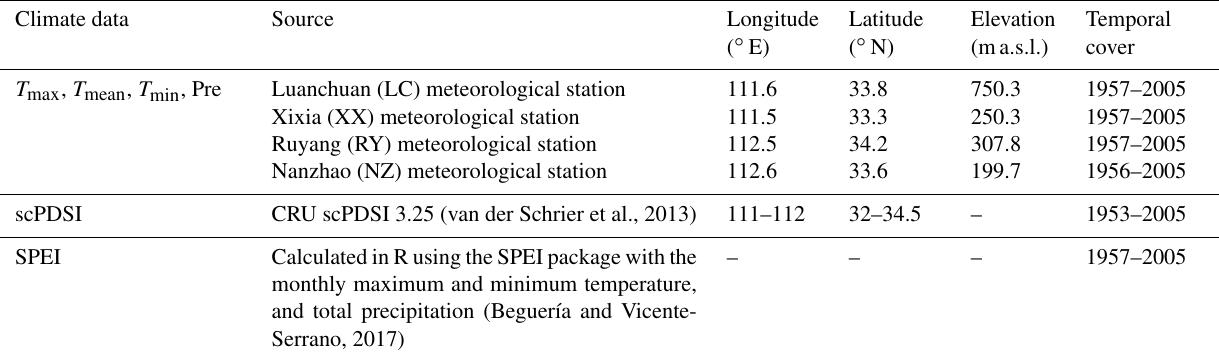
Table 1. Characteristics of climate data series used in correlation analyses. Climate data Source